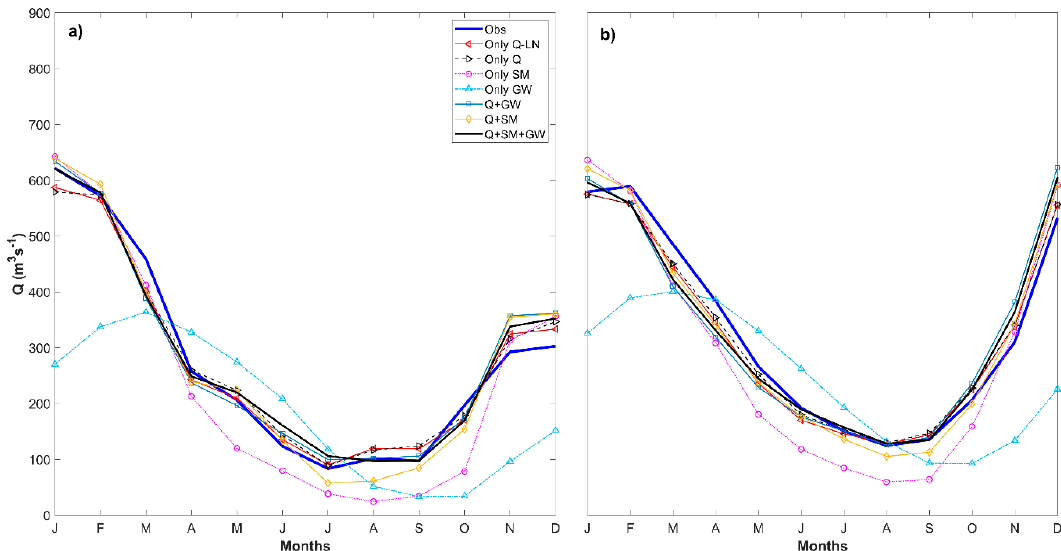
Figure 5. Observed average monthly discharge at the Cochem Gauge, and simulated average monthly discharge from HBV model for the ( a ) calibration (2002–2006) and ( b ) validation (1954–2001) periods for seven cases calibrated by the CMAES global search algorithm .